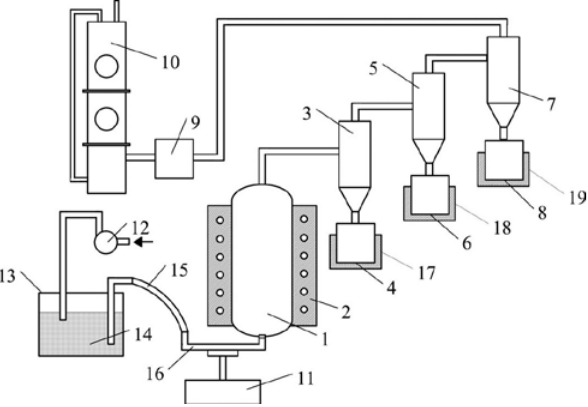
Figure 1: Schematic diagram of automated spray pyrolysis experimental device. (1) Corundum tube, (2) tubular furnace, (3) the first-stage cyclone, (4) the first stage collector, (5) the second level cyclone separator, (6) the second stage collector, (7) the third cyclone, (8) the third stage collector, (9) flow controllers, (10) tail gas absorber, (11) lifting device, (12) air compressor, (13) tank, (14) solution, (15) hose, (16) injection pipe, (17–19) water bath tempera- ture